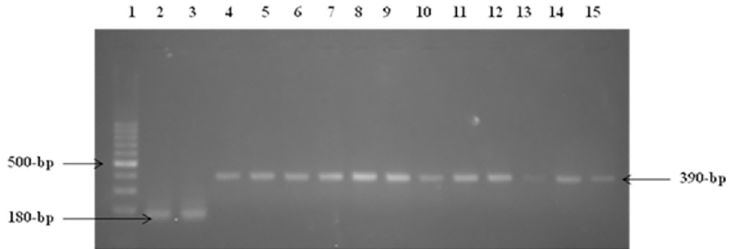
Fig 8. RT-PCR of single clones of cell lines 293T/P2X4 and 293T/NV. Lane 1 showed: 100-bp DNA size marker, Lanes 2 &3 showing amplified product of NV (180-bp), Lanes4-15 showed amplified product of transfected P2X4